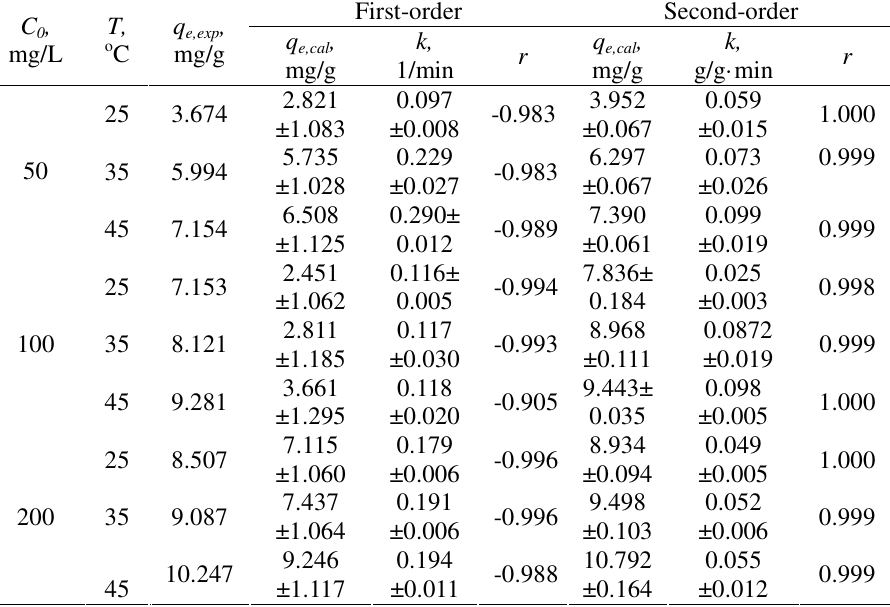
Table 6. Comparison of the adsorption kinetic models of PVA (700) on EG First-order Second-order C 0